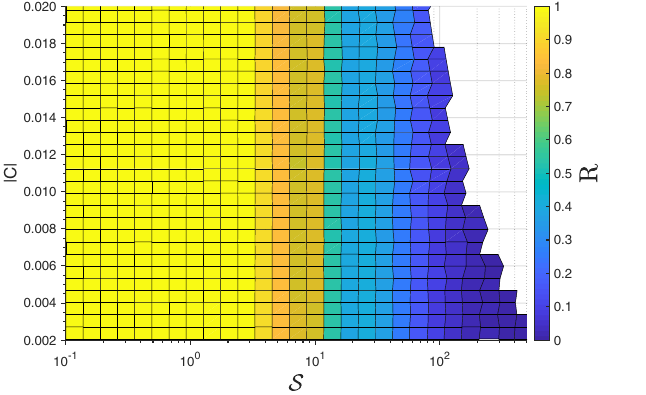
FIG. 4. Quality of emittance exchange as a function of the scaling parameter for the SLS booster lattice.